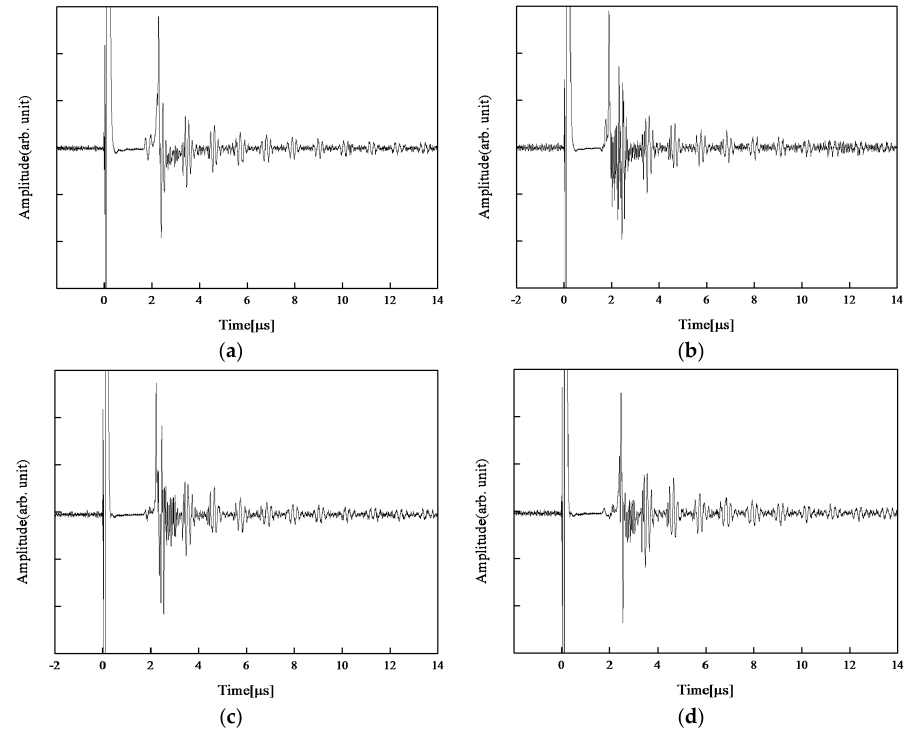
Figure 5. Sensitivity of CBT/PZT films fabricated on 3-mm-thick 900 mm 2 titanium substrate at various temperatures during thermal cycle.